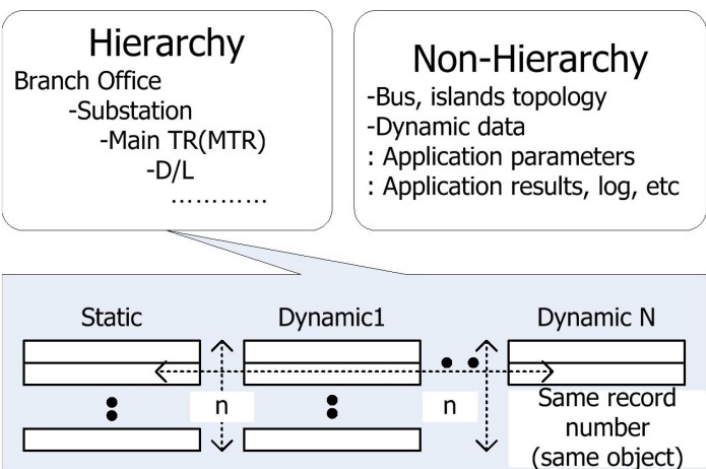
Figure 12. Parallel table